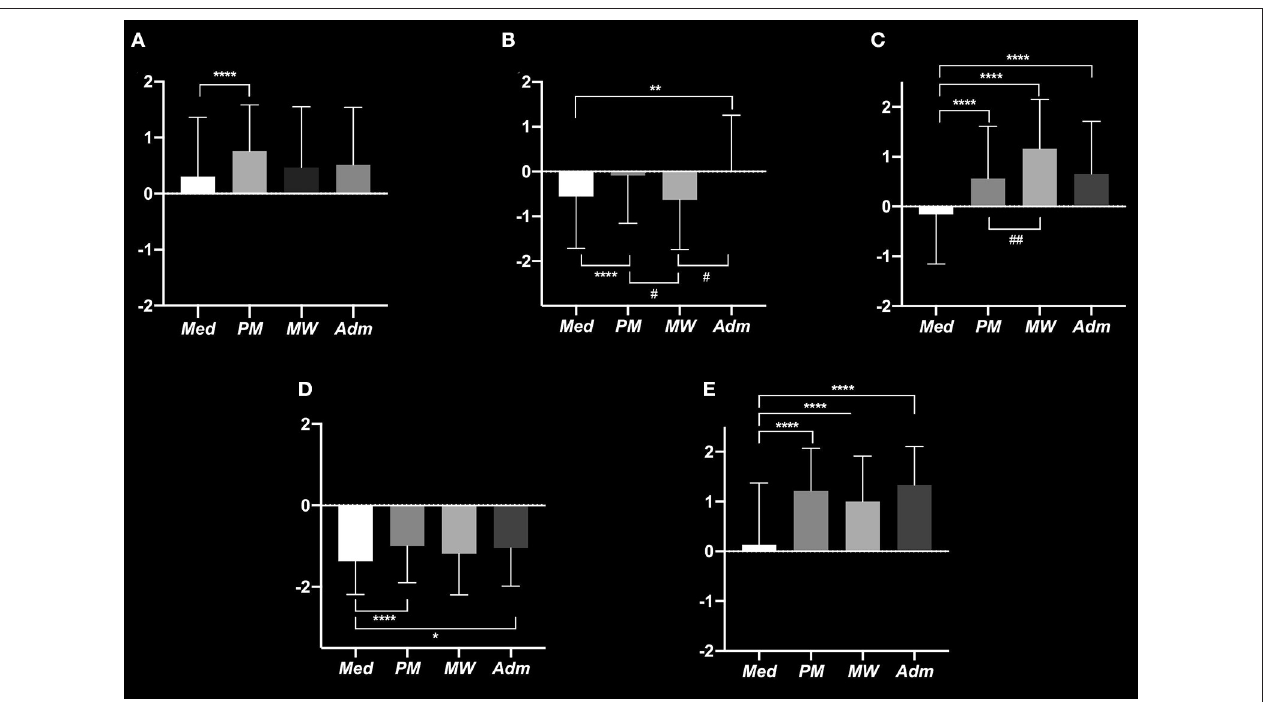
FIGURE 3 | Mean Evaluation on a Likert scale from -2 to + 2 for: Question 2, Is the anesthesiologist a professional available? (A) Question 3, Is the anesthesiologist a service provider? (B) Question 8, Is the anesthesiologist a professional recognized by the patient? (C) Question 22, All acts of anesthesia can be transferred to the